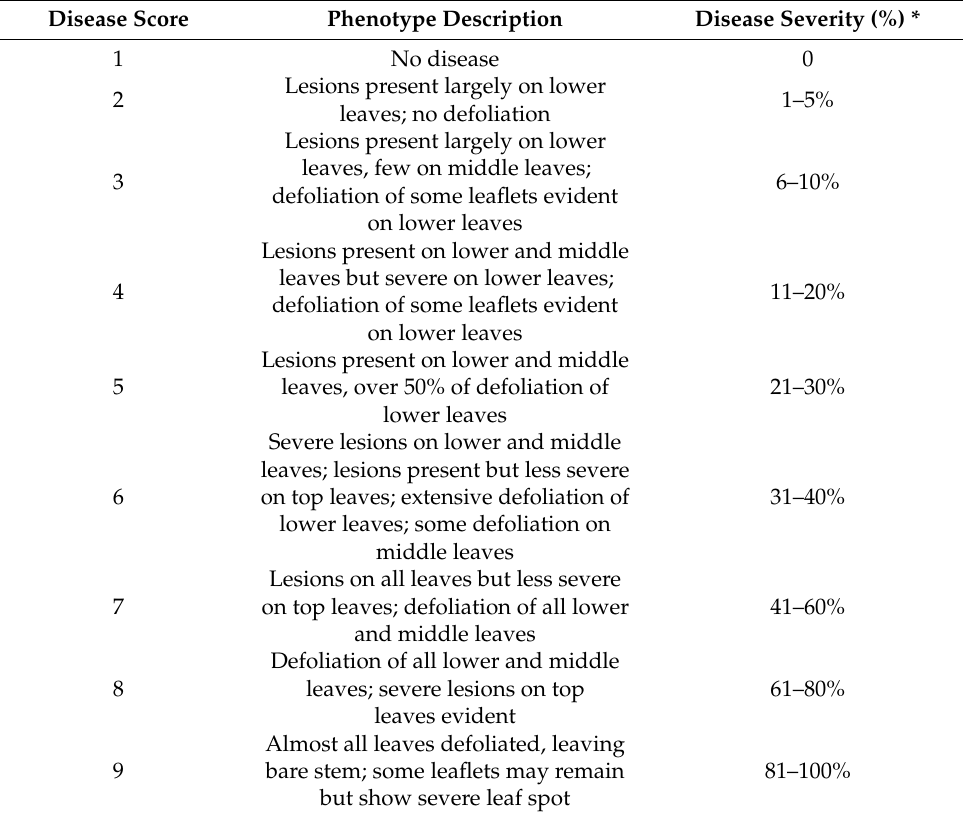
Table 2. Modified 9-point scale for LLS used for field screening of